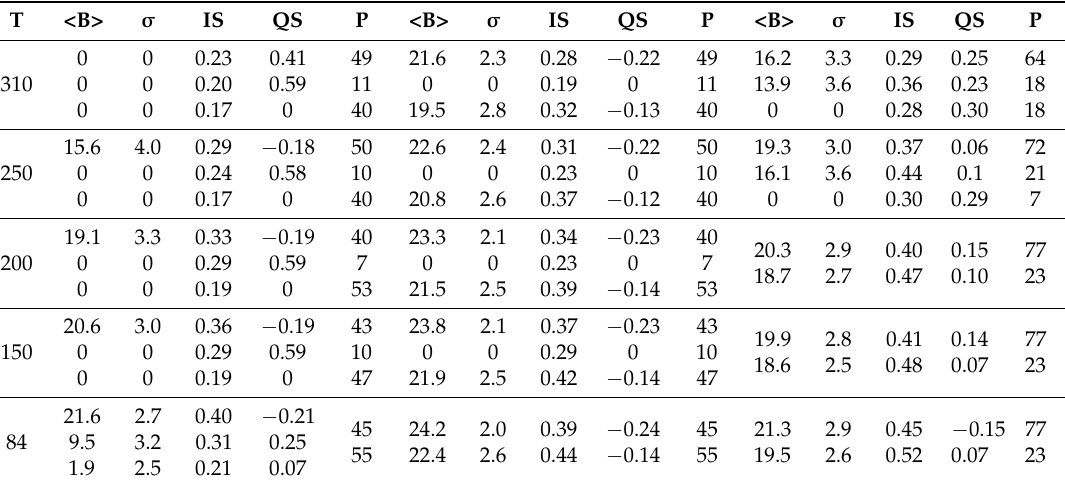
Table 4. Results of Mössbauer studies of the Fe-poor Mn 1.4 Fe 0.6 P 0.3 Si 0.7 (columns 2 to 6), the